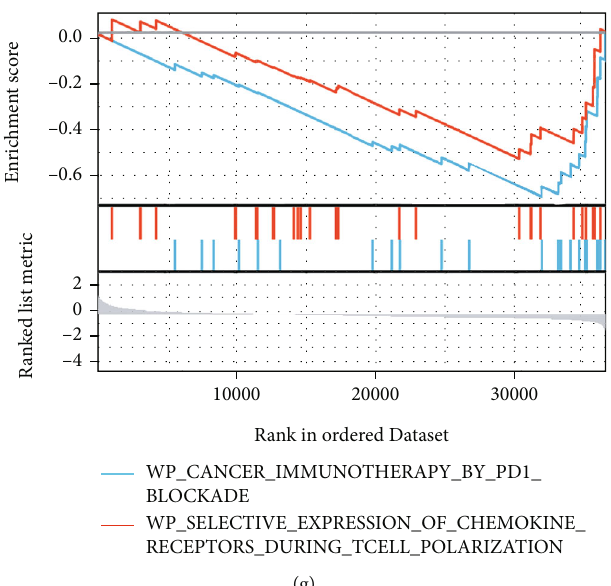
Figure 5: Function and pathway enrichment analyses of BCHE in EC. (a – c) Signi fi cant Gene Ontology terms associated with BCHE, including biological processes (BP), cell component (CC), and molecular function (MF). (d – g) Signi fi cant GSEA results associated with BCHE, including (d) KEGG pathways, (e) REACTOME pathways, (f) PID pathways, and (g) WP